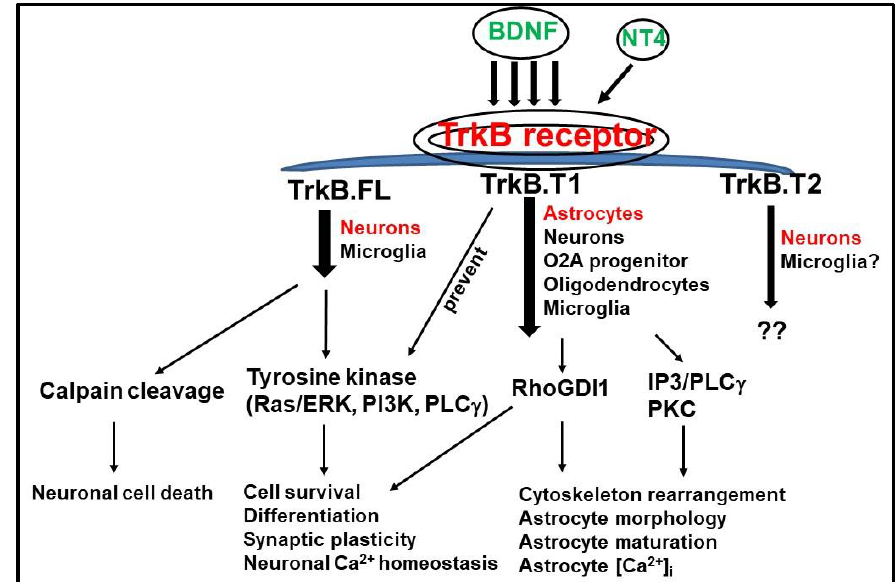
Figure 1. Tyrosine receptor kinase B (TrkB) receptor isoform expression and signaling in the central nervous system. TrkB.T1 is predominantly expressed in astrocytes, whereas TrkB.TL is highly expressed in neurons. Although TrkB.T2 was reported to be expressed by neurons, its function is unknown. Oligodendrocyte-type-2 astrocyte lineage (O2A progenitor). Rho guanosine diphosphate dissociation inhibitor (RhoGDI1).